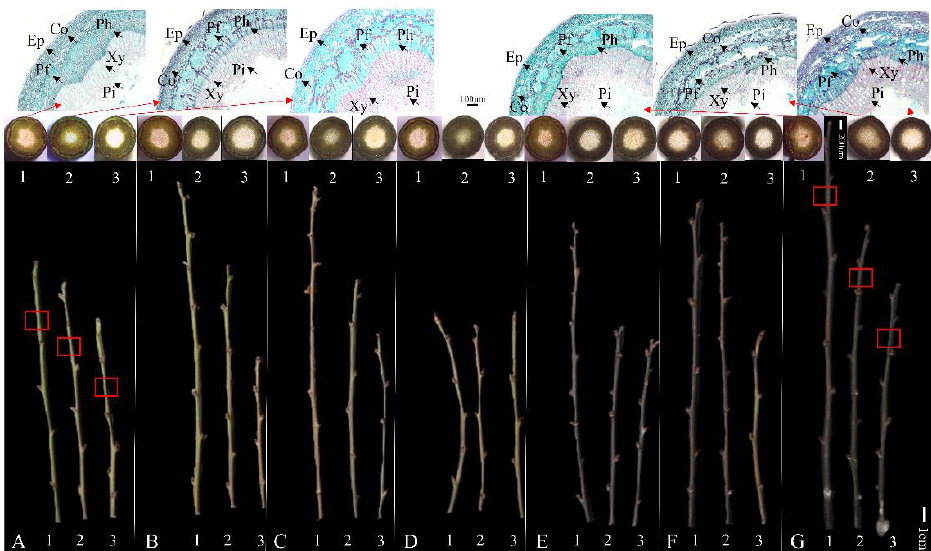
Figure 4. Freehand and paraffin slices of three P. mume variety one-year-old branches under cryogenic